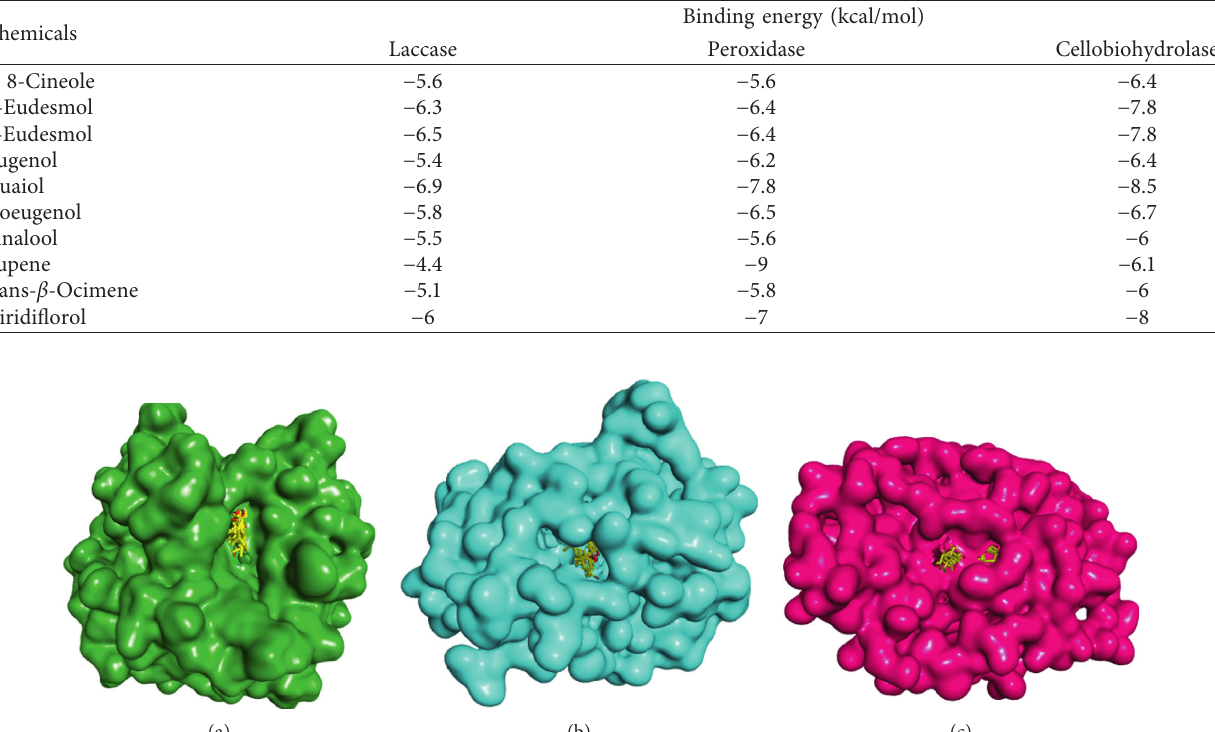
Table 2: Binding energy of the interaction between chemicals in cajuput leaf oil and the enzymes (laccase, peroxidase, and cellobiohydrolase).